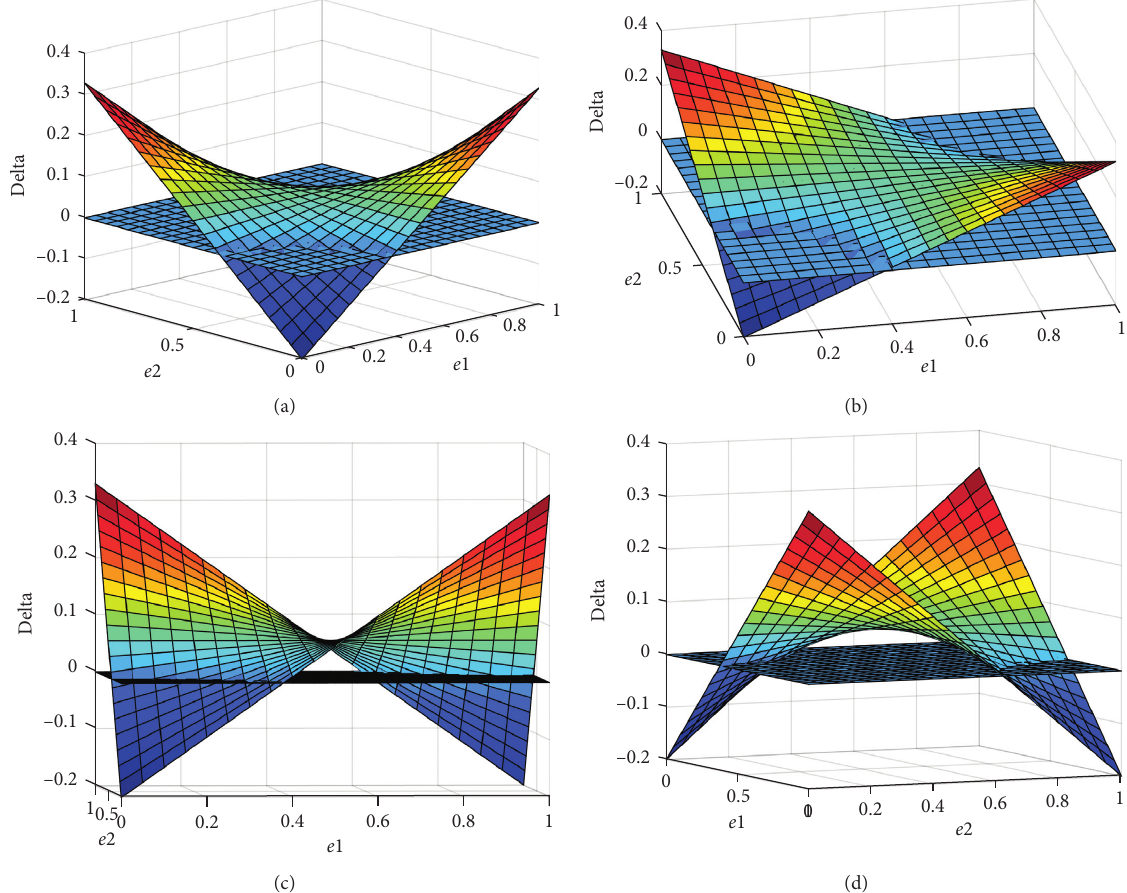
Figure 5: Size relationship (the x label e 1 represents ε